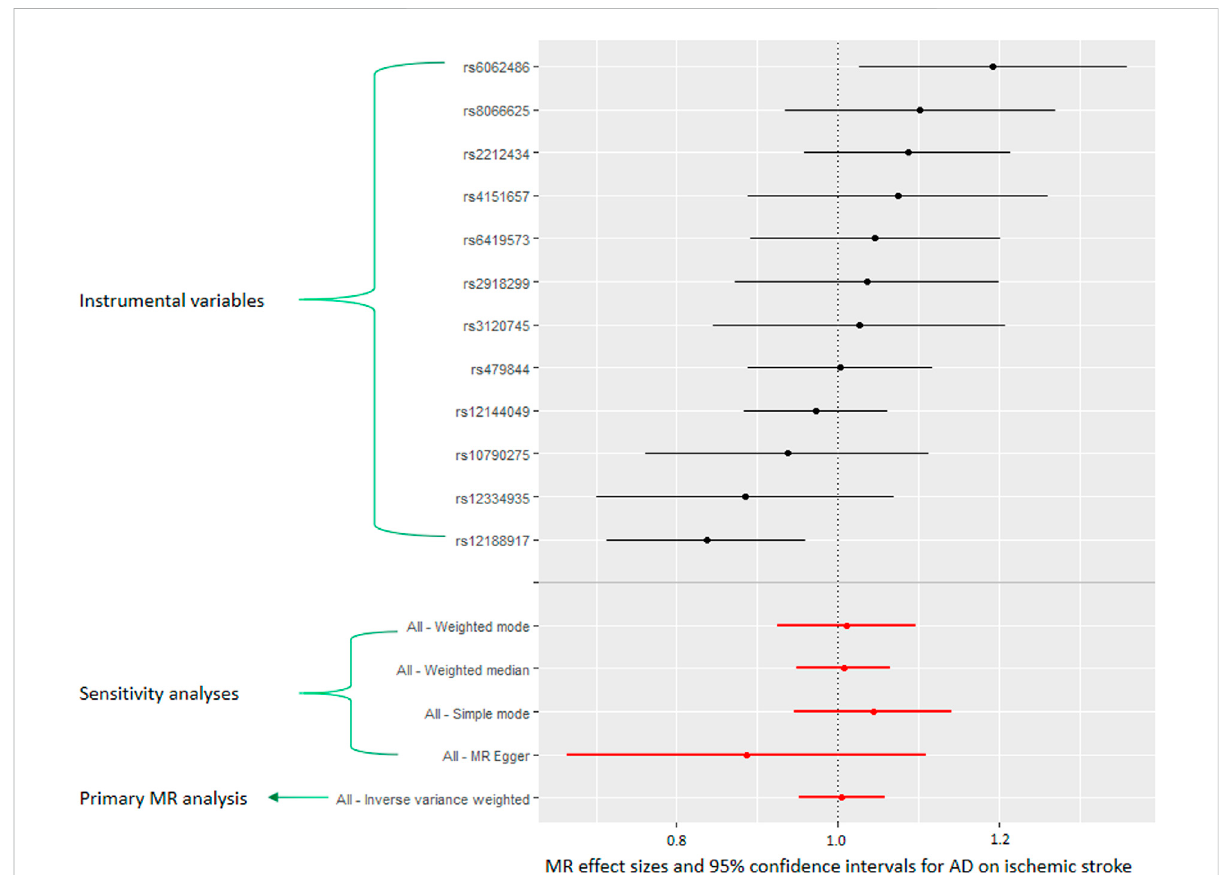
FIGURE 1 Meta-analytic Mendelian randomization (MR) effect estimates (odds ratios) and 95% con fi dence intervals for the association between atopic dermatitis (AD) and ischemic stroke. The inverse variance weighted (IVW) method was used in the primary MR analysis. In addition, we performed sensitivity analyses using MR-Egger, weighted median, weighted mode, and simple mode methods.